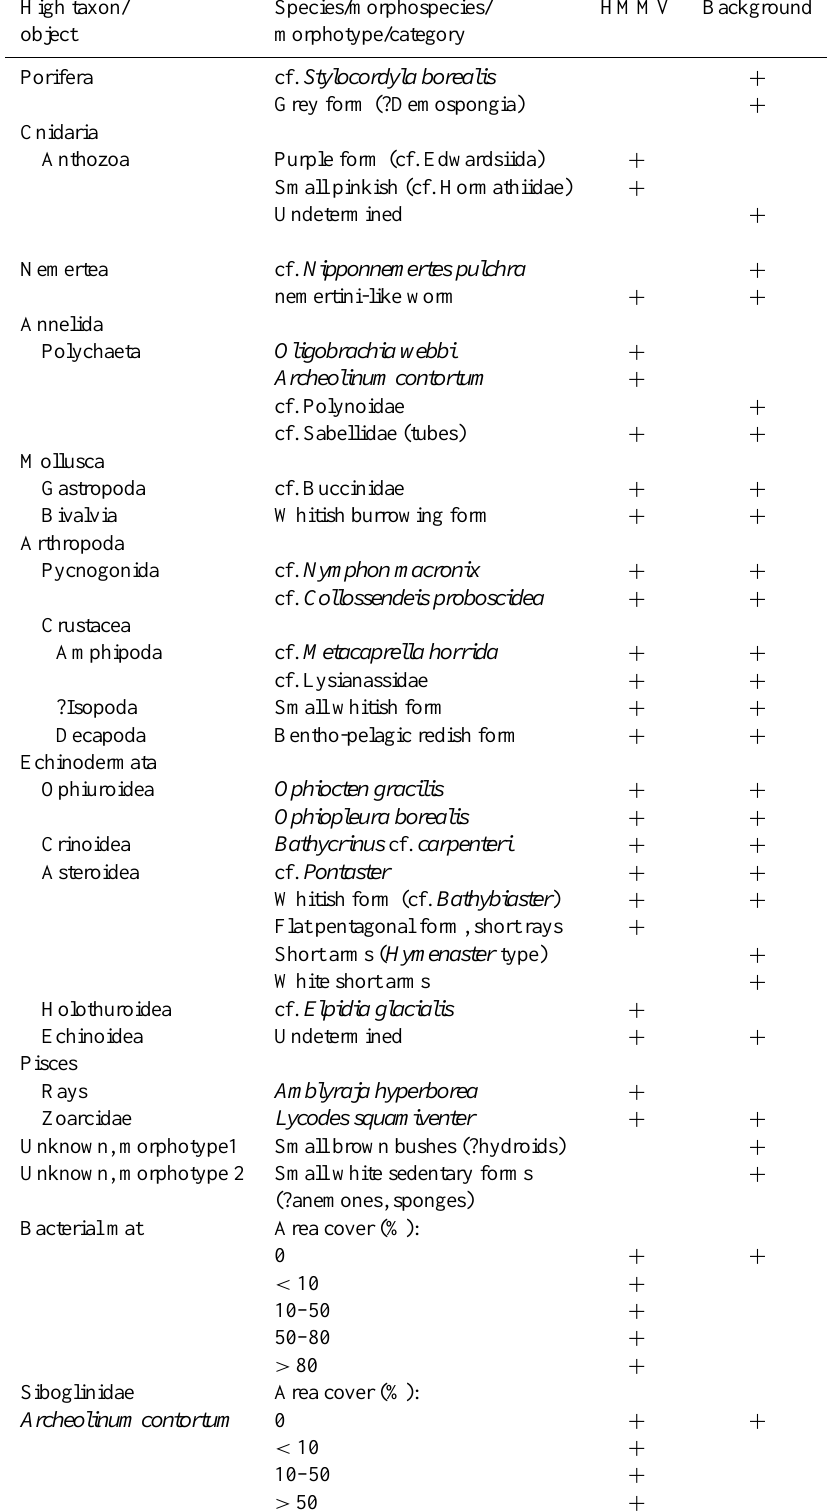
Table 2. Megafauna and other categories recorded on OFOS